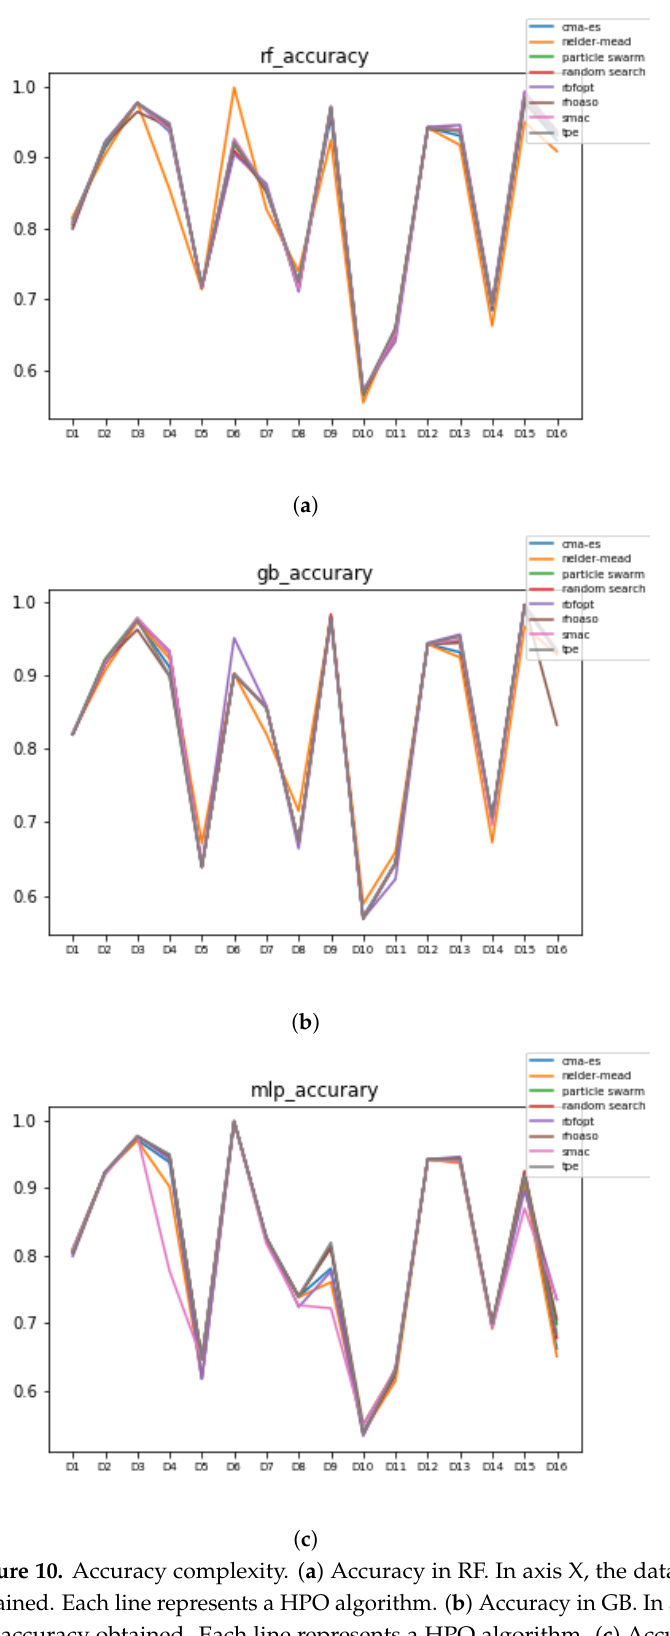
Figure 10. Accuracy complexity. ( a ) Accuracy in RF. In axis X, the dataset. In axis Y, the accuracy obtained. Each line represents a HPO algorithm. ( b ) Accuracy in GB. In axis X, the dataset. In axis Y, the accuracy obtained. Each line represents a HPO algorithm. ( c ) Accuracy in MLP. In axis X, the dataset. In axis Y, the accuracy obtained. Each line represents a HPO